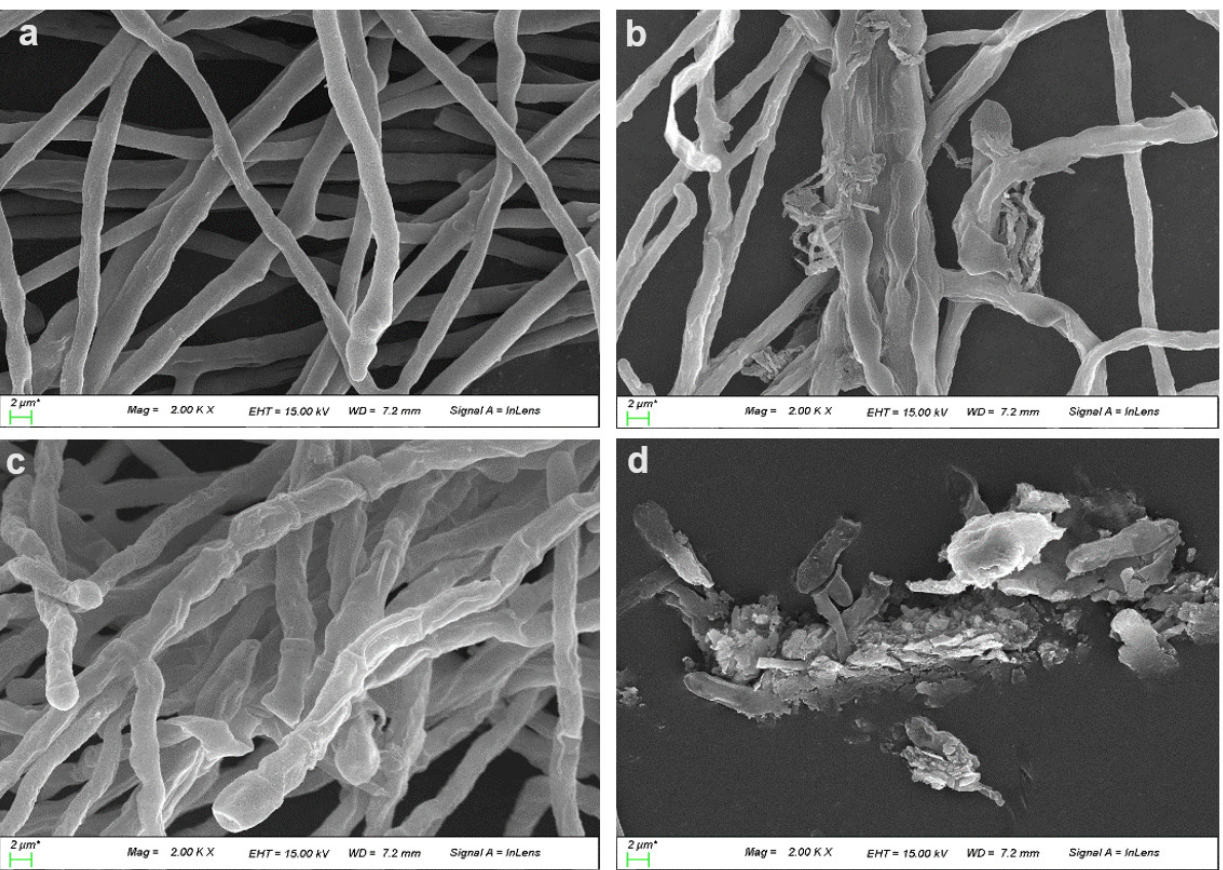
Figure 9. Hyphal deformation of C. gloeosporioides caused by 1 mg/mL ( b ), 2 mg/mL ( c ), and deformation of conidia caused by 3 mg/mL of the purified dipeptide, cyclo-(D-phenylalanyl-D-prolyl) ( d ) compared to the untreated control with normal hyphal formation ( a ) at 24 h after incubation as observed under scanning electron